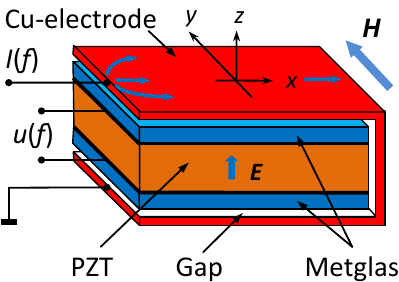
Figure 12. Schematic view of a Metglas/PZT/Metglas heterostructure placed inside the “magnetic capacitor”. The arrows show directions of electric E and magnetic H fields.